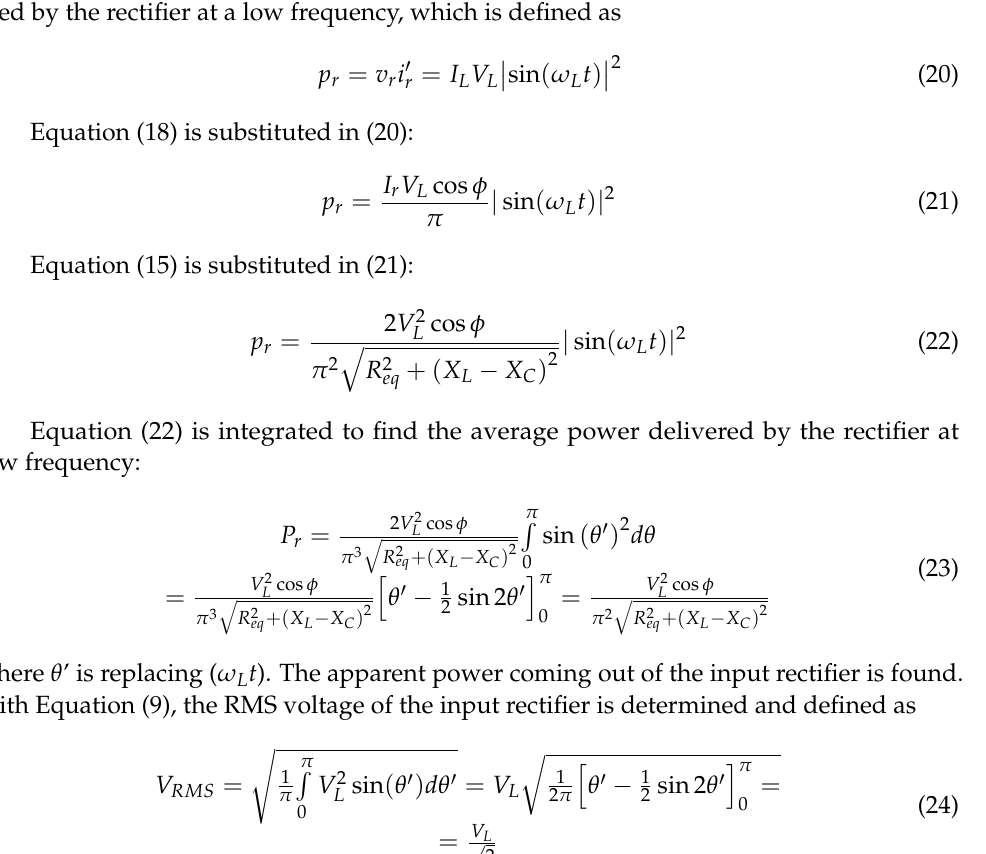
Figure 13. Instantaneous current delivered by the rectifier seen at a high frequency. With Equations (19) and (9), it is possible to calculate the instantaneous power deliv-